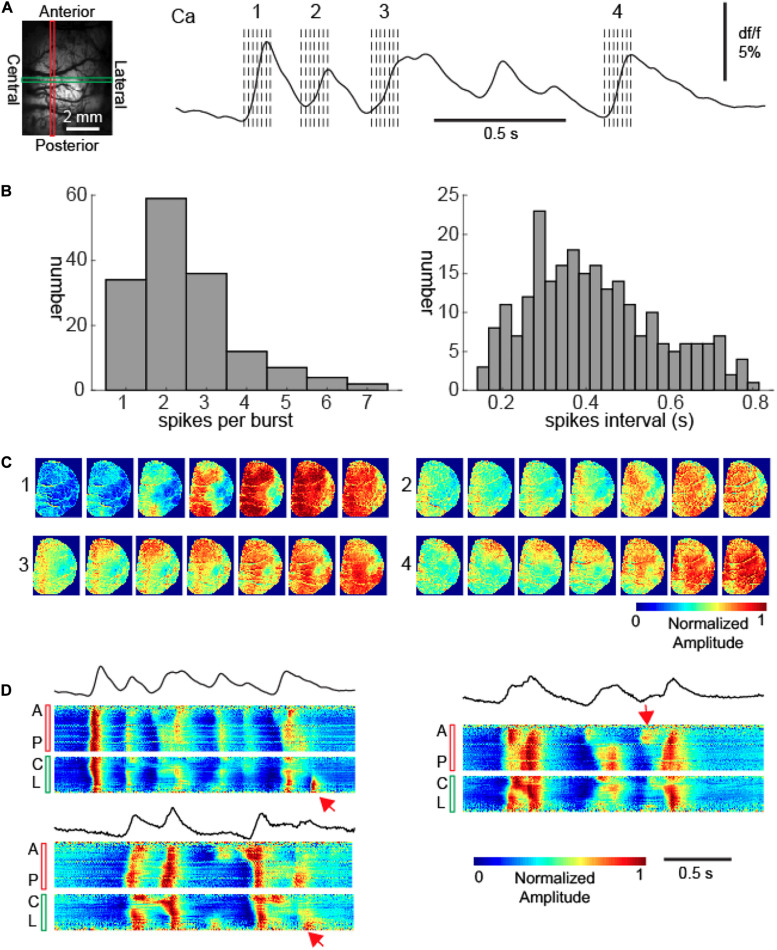
Recurrent calcium waves with asynchrony during bursts. (A) Left: the field of view. A vertical red rectangle and a horizontal green rectangle represent two intersecting linear regions of interest (LROI). The calcium signals from each of these LROIs are further displayed in Panel (D). Right: the calcium signal recorded from the intersection of the two LROIs. The spatiotemporal evolution of four calcium waves are further displayed in Panel (C). The dashed lines indicate the timing of images displayed in Panel (C). (B) Left: the distribution of waves per burst. Right: the distribution of inter-wave intervals within bursts. (C) The propagation patterns of four calcium waves within a burst. Notice the variation of cortical onset sites and propagation patterns. (D) The calcium signals from the LROIs. Three bursts are displayed, with the upper left one corresponding to the burst displayed in Panel (A). The top black traces: the average calcium signals of all pixels. The bottom color panels show the vertical anterior-posterior (A-P) and horizontal central-lateral (C-L) propagation of calcium waves from the LROIs. The red arrows provide examples where waves propagated only locally.